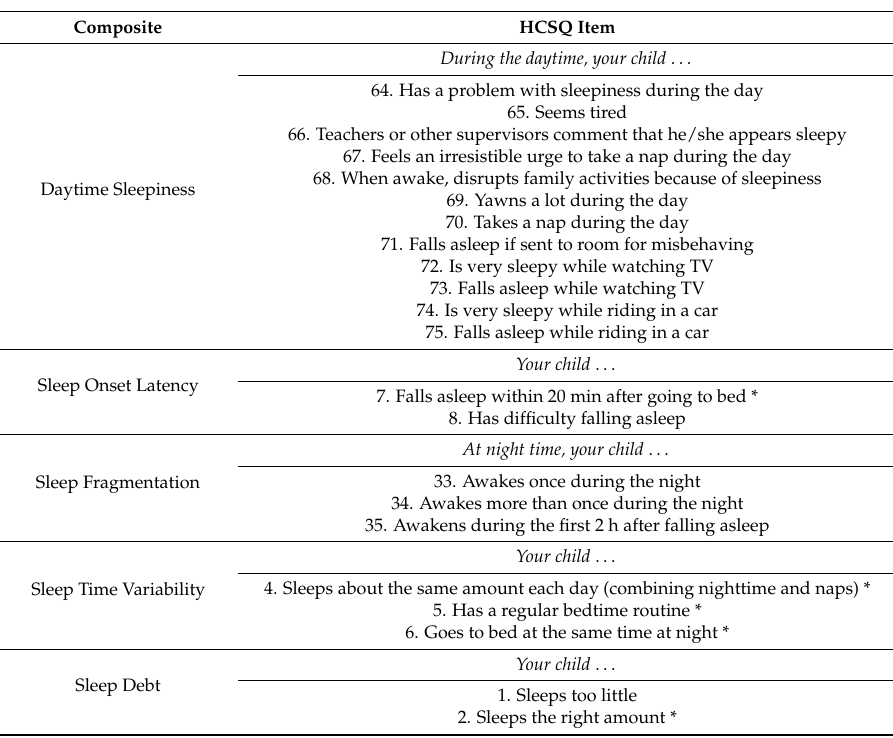
Table 3. Sleep-Related Problems Composite